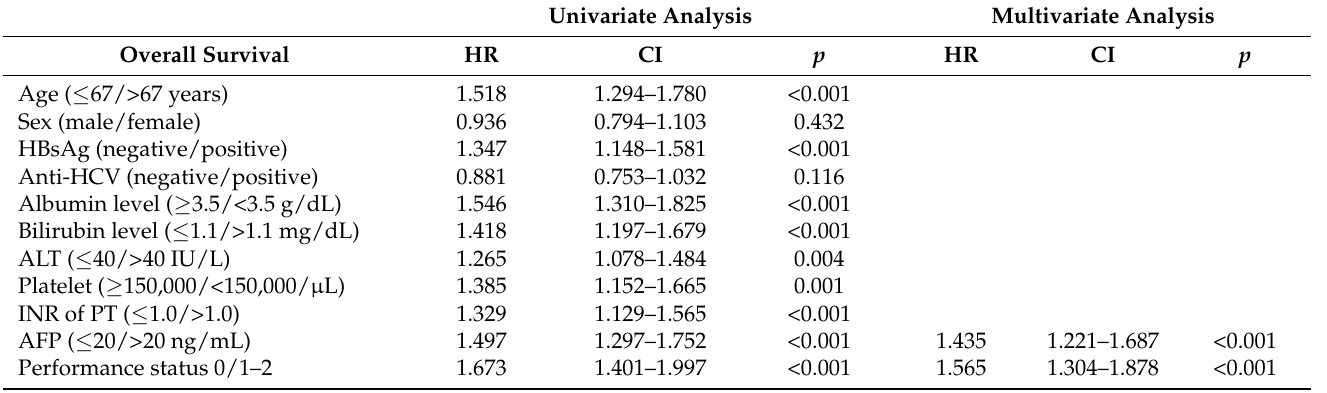
Table 2. Multivariate analysis of overall survival in HCC patients within Milan criteria undergoing radiofrequency ablation or transarterial chemoembolization (n = 883). Univariate Analysis Multivariate Analysis